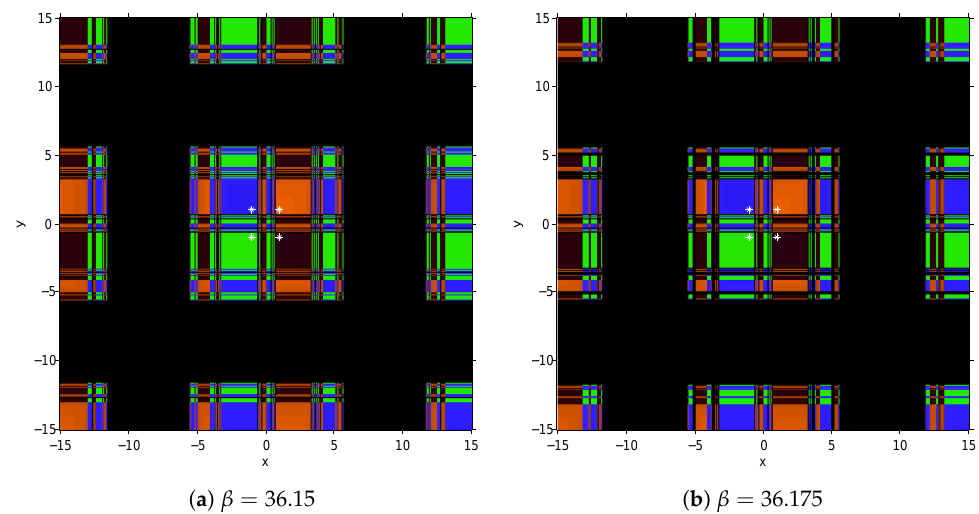
Figure 9. Dynamical planes for stable values of β of class M42 on p ( x )